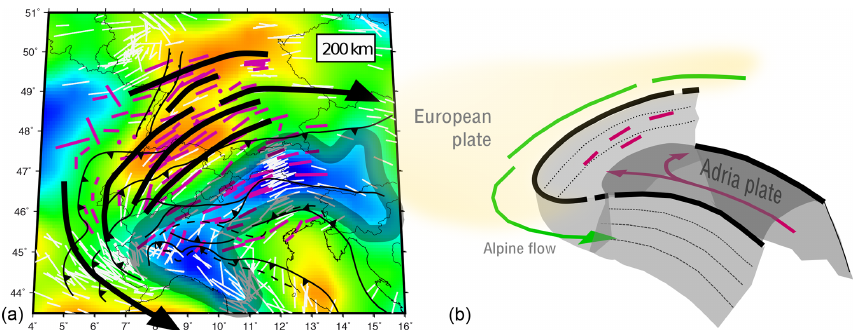
Figure 8. (a) Seismic tomography model of the Alpine region at 200km depth from Zhu et al. (2015) with overlain SKS measurements (white – previous studies, pink – this study). Black arrows are the authors’ interpretation of a possible mantle flow around the barrier slabs (outlined with a thick grey line). (b) Sketch of possible mantle flow patterns based on our SKS measurements, indicating the possible barrier effect of the Alpine and Adria